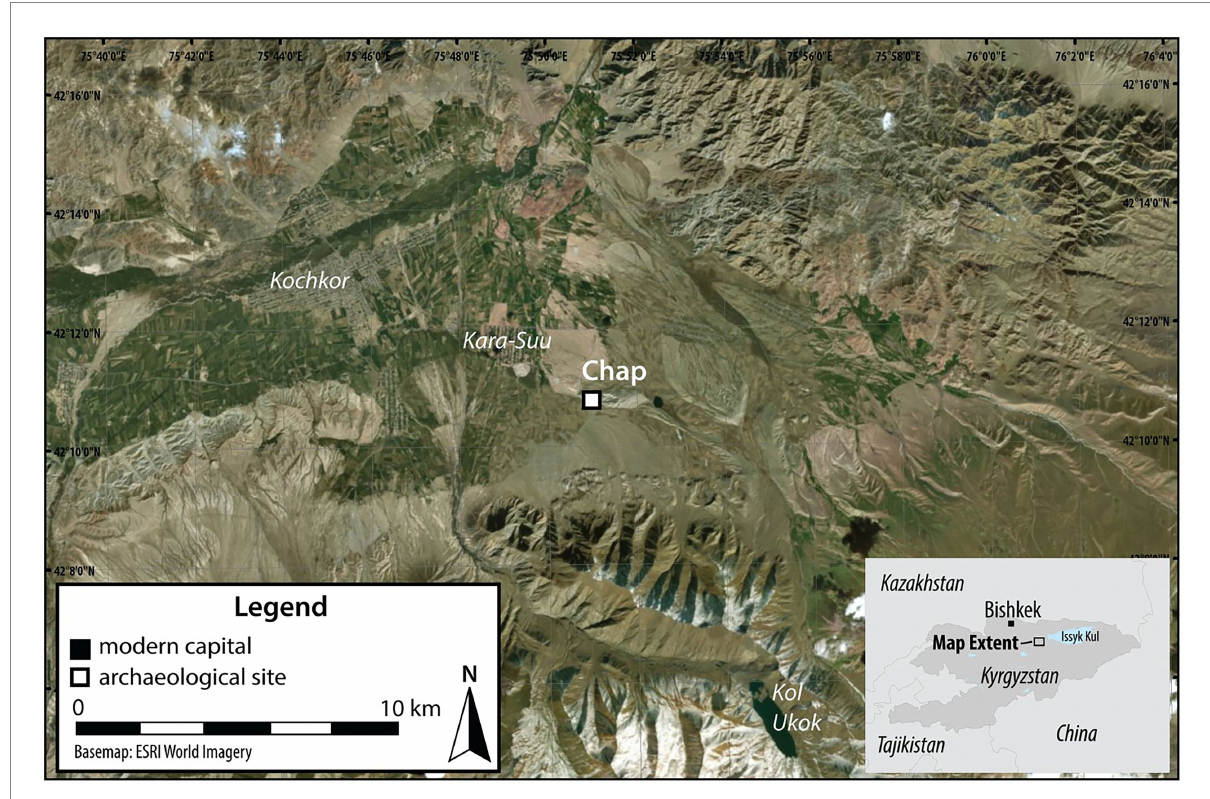
FIGURE 1 Location of the study site of Chap in Kyrgyzstan’s Tien Shan along the